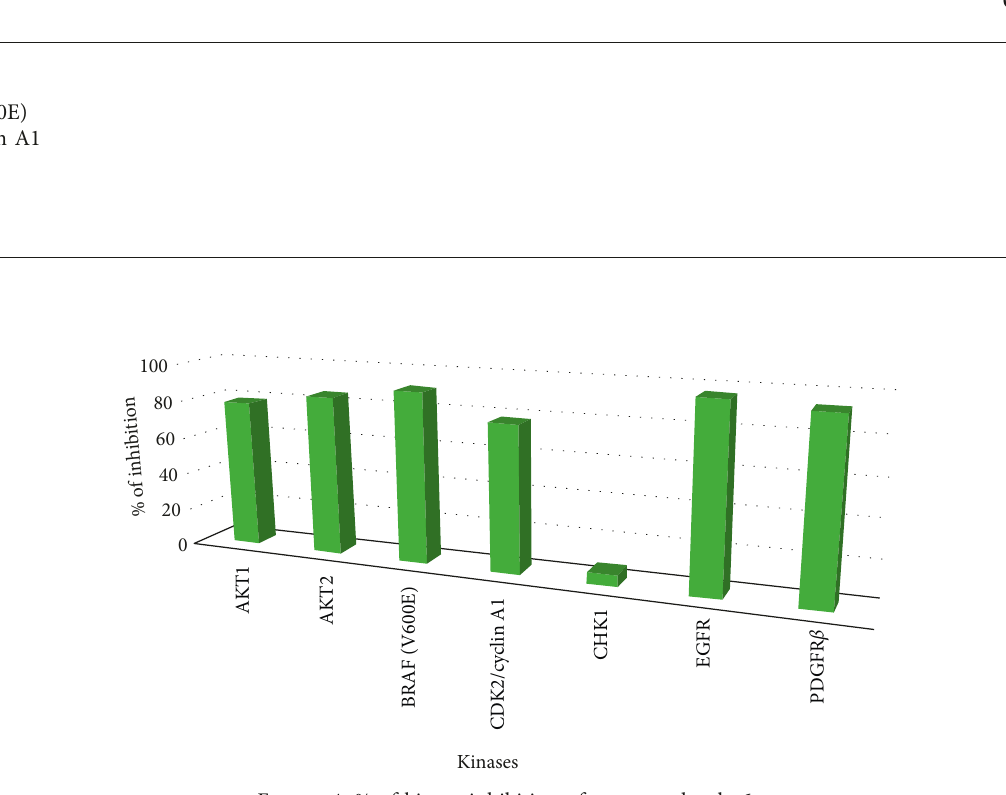
Figure 4: % of kinase inhibition of target molecule 6